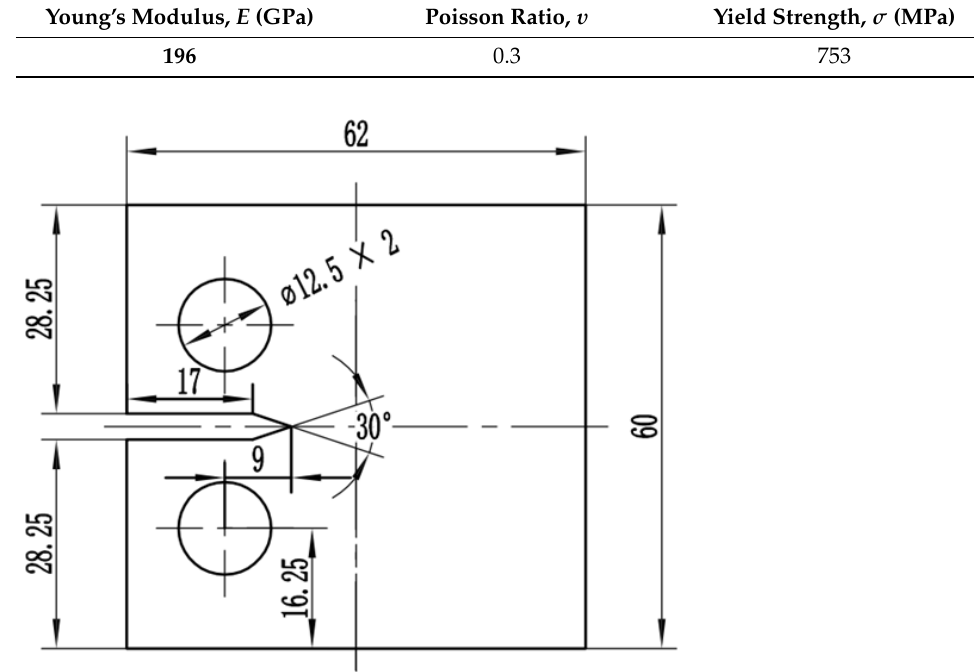
Figure 2. Geometric dimensions of CT specimen. Table 1. Mechanical properties fo r Q&P980.